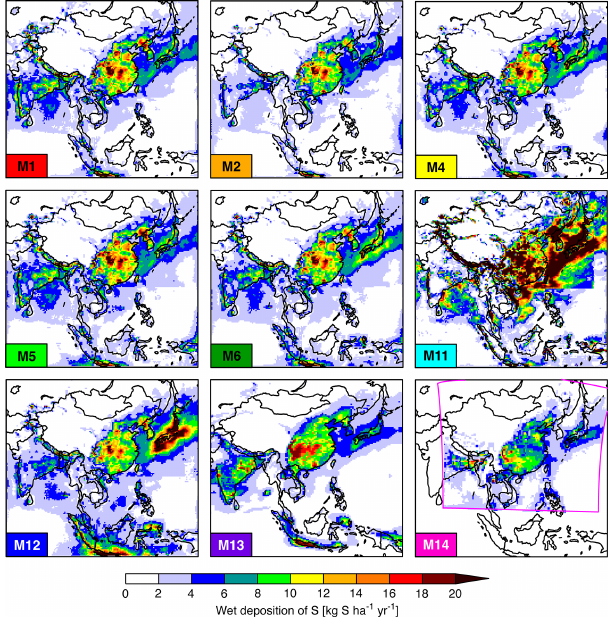
Figure 4. Spatial distributions of the annual accumulated wet depo- sition of